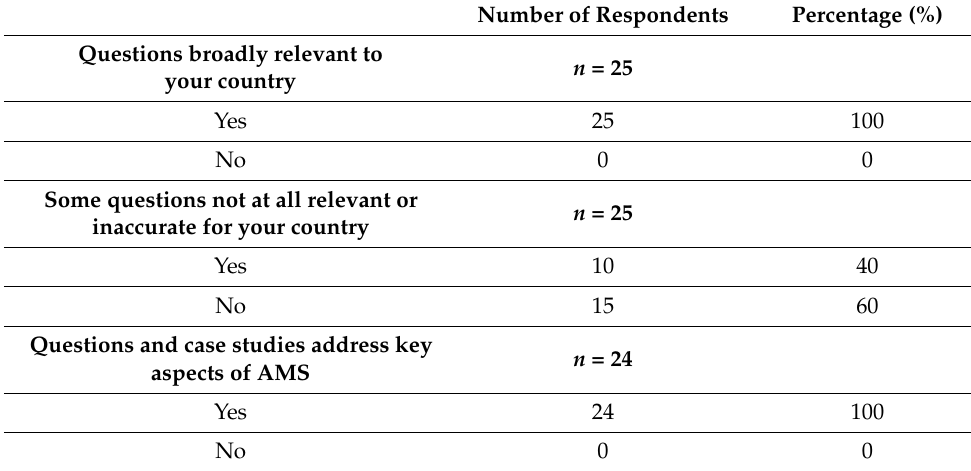
Table 1. Respondents’ feedback on relevance of